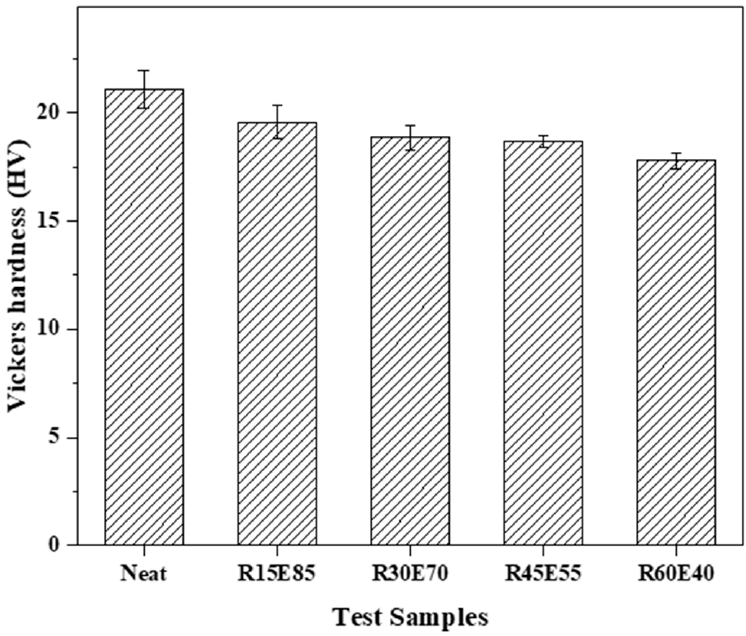
Figure 7. Vickers hardness of test samples.